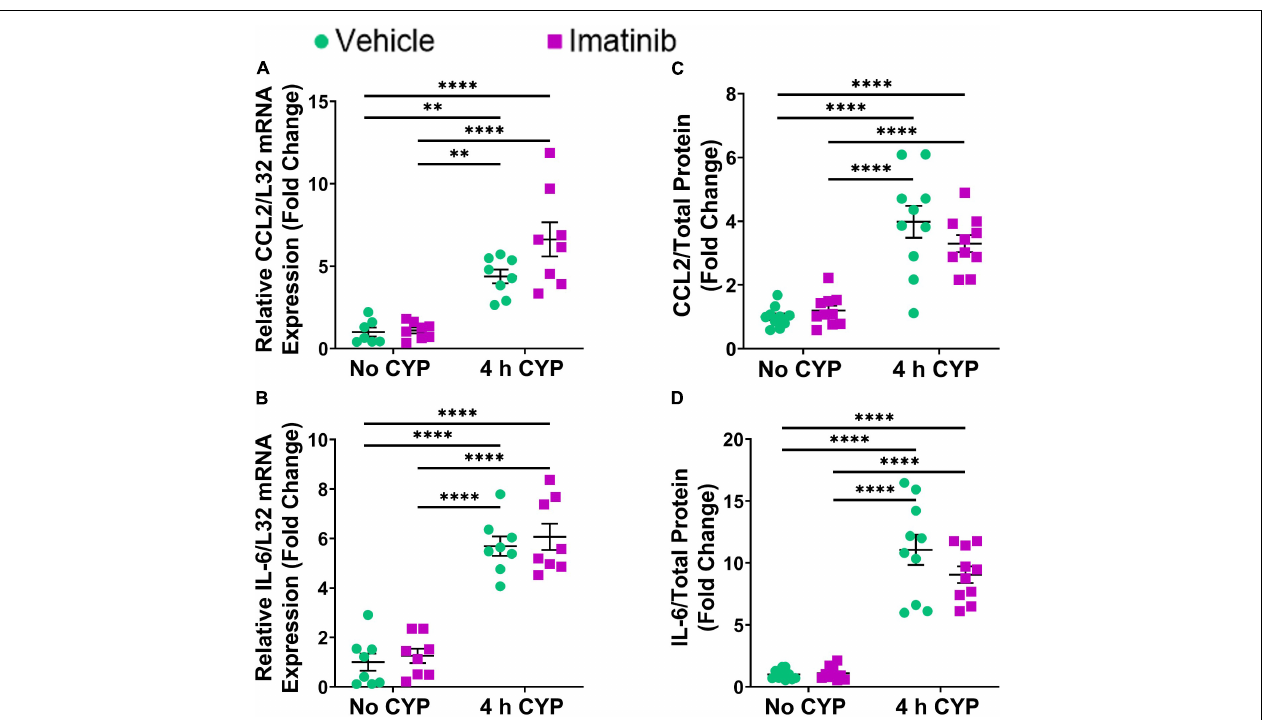
FIGURE 4 | Transurethral bladder infusion of imatinib mesylate does not significantly affect CCL2 and IL-6 mRNA transcript (lamina propria, LP) or protein (whole urinary bladder) expression in an acute (4 h) cyclophosphamide (CYP)-induced cystitis female mouse model. Acute (4 h) CYP treatment (200 mg/kg, i.p.) significantly (0.0001 ≤ p ≤ 0.01) increased (A) CCL2 (4.4-fold) and (B) IL-6 (5.7-fold) mRNA transcript expression in the bladder LP, and (C) CCL2 (4-fold) and (D) IL-6 (11.1-fold) whole bladder protein expression in female mice that received vehicle (saline) intravesical infusion 4 h post CYP injection, compared to vehicle infused control. Imatinib treatment via transurethral intravesical infusion (50 µ M, 30 min) 4 h post CYP administration, did not significantly affect (A) CCL2 or (B) IL-6 mRNA transcript expression in the bladder LP, nor (C) CCL2 or (D) IL-6 protein expression in whole bladder samples in female mice with 4 h CYP-induced cystitis. mRNA transcript and protein expression were measured by real time qRT-PCR and ELISAs, respectively. mRNA transcript expression was normalized to expression of the house keeping gene, L32. Raw mRNA transcript and ELISA values (pg/mL) are presented as fold change values ± SEM with respect to the control group (vehicle, no CYP). n = 7–10. * p ≤ 0.05; ** p ≤ 0.01; *** p ≤ 0.001; **** p ≤ 0.0001 by two-way ANOVA with Tukey’s multiple comparisons